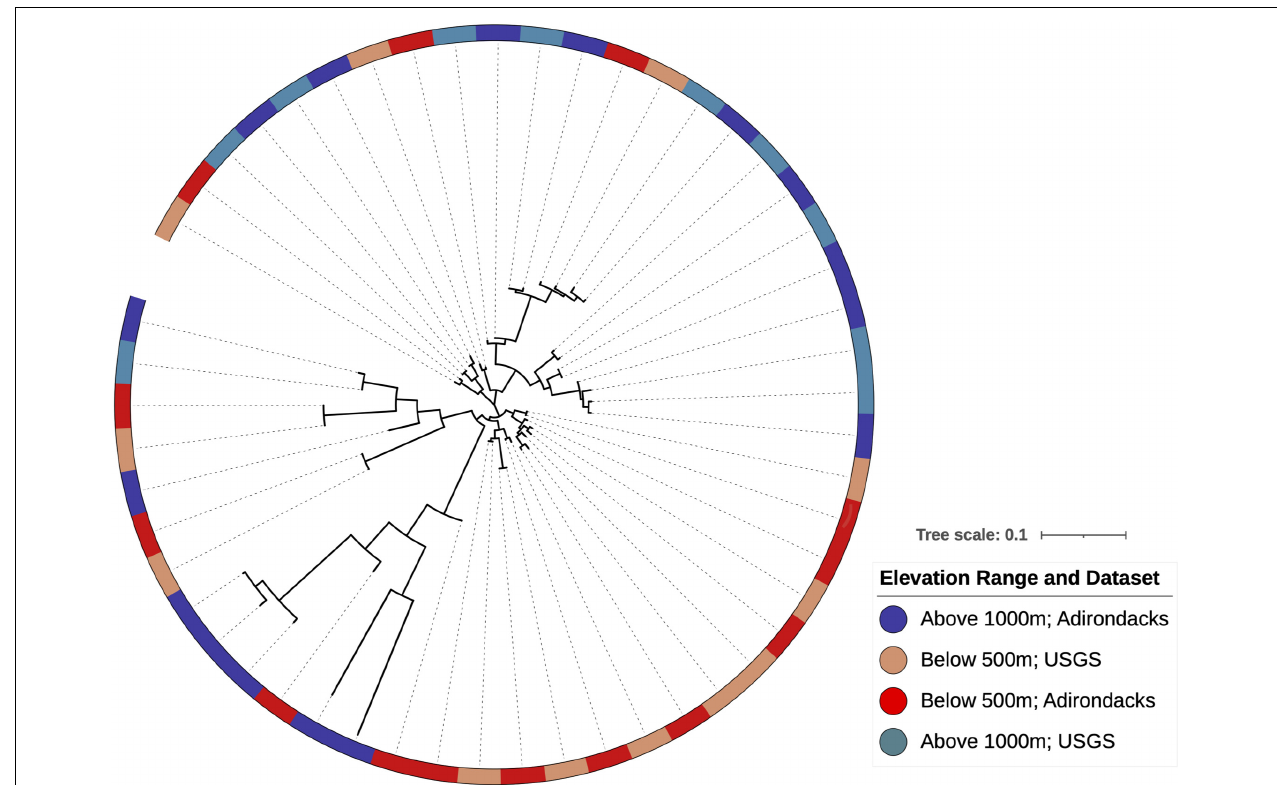
FIGURE 7 | Phylogenetic reconstruction of indicator OTU lineages shows clade-level conservation of elevational preferences within Streptomyces found at WM. Some clades show mixed elevation preferences with branch lengths suggesting that indicator OTUs above 1,000 m have greater evolutionary divergence relative to those found at lower elevations. Colors are indicative of elevation and dataset for each OTU as indicated in the